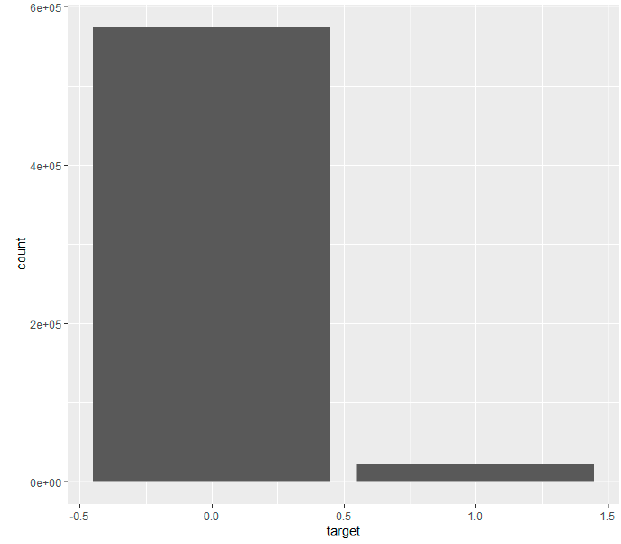
Figure 5. Histogram of the distribution of target values.